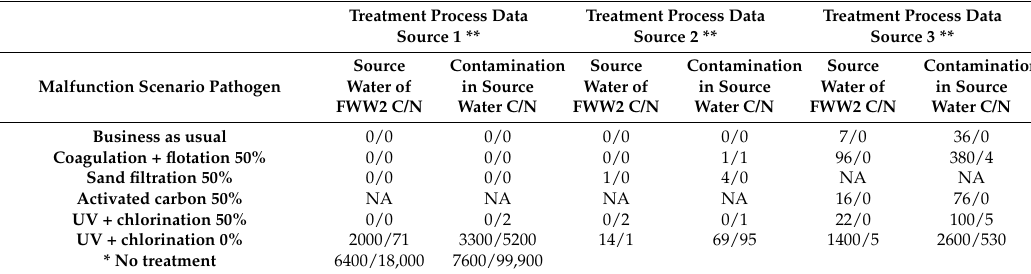
Table 4. Number of Campylobacter (C) and norovirus (N) illness cases in population of 100,000 per day under the waterworks malfunction situations. Results are calculated based on literature, PWW or PWW + literature removal efficiency with two source waters (Table